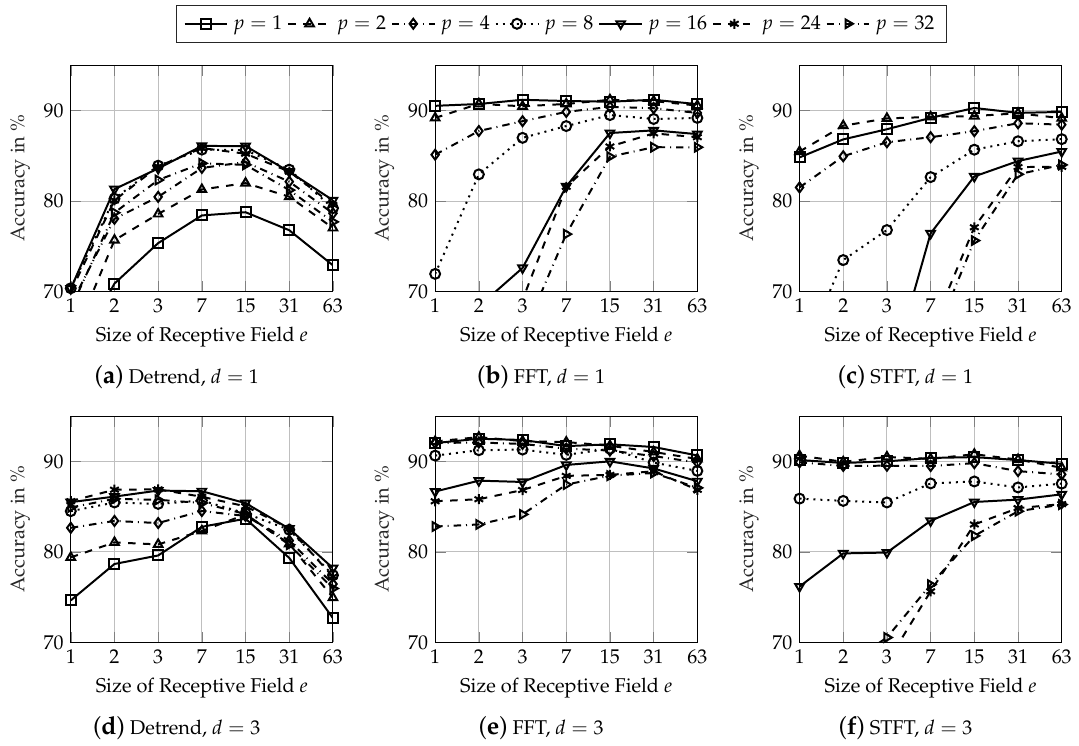
Figure 5. Mean test data accuracy of a 5-fold cross-validation for the investigation of the network architecture. p is the size of the pooling layer (with p = 1 effectively resulting in no pooling), e is the spatial extent of a kernel (for STFT the size of the receptive field is e × e